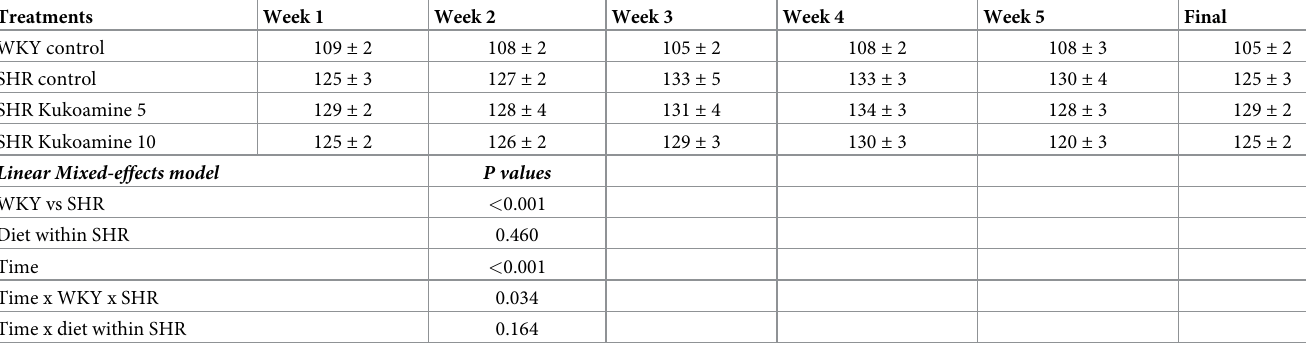
Table 2. Weekly mean food intakes (g) of the rats on the experimental treatments 1